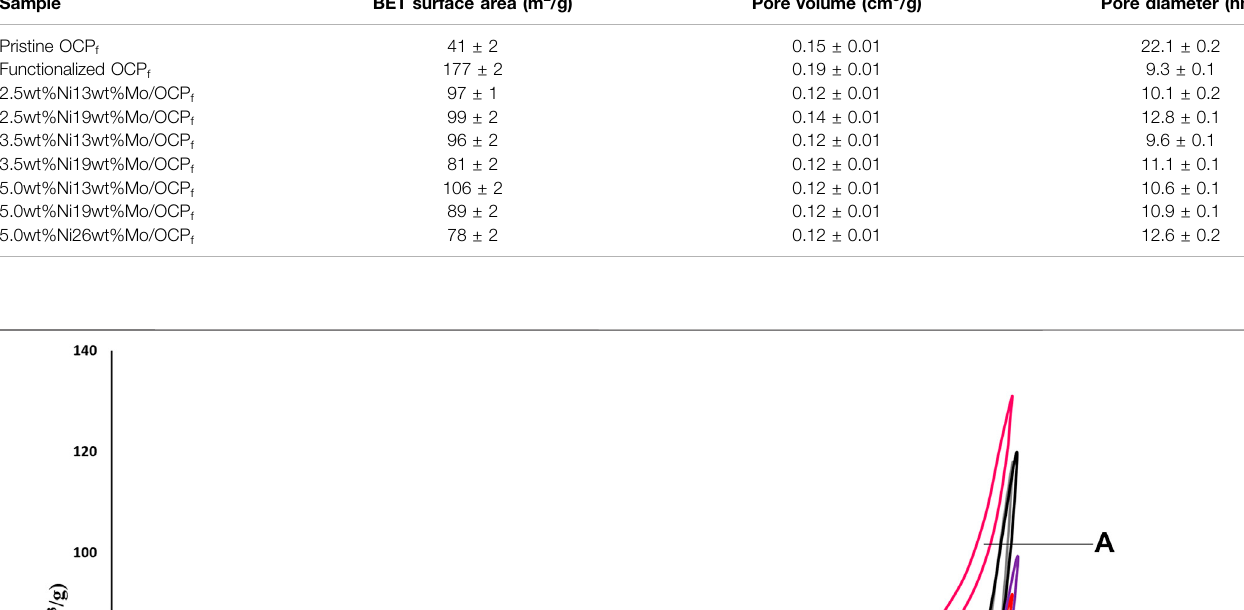
TABLE 1 | BET analysis of pristine OCP f , functionalized OCP f , and NiMo/OCP f catalysts. Sample